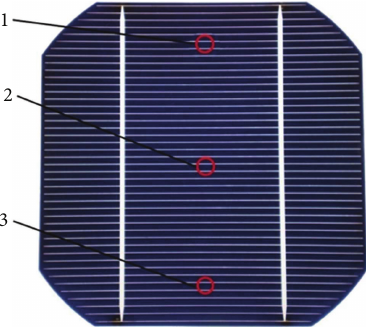
Figure 10: Solar cell.